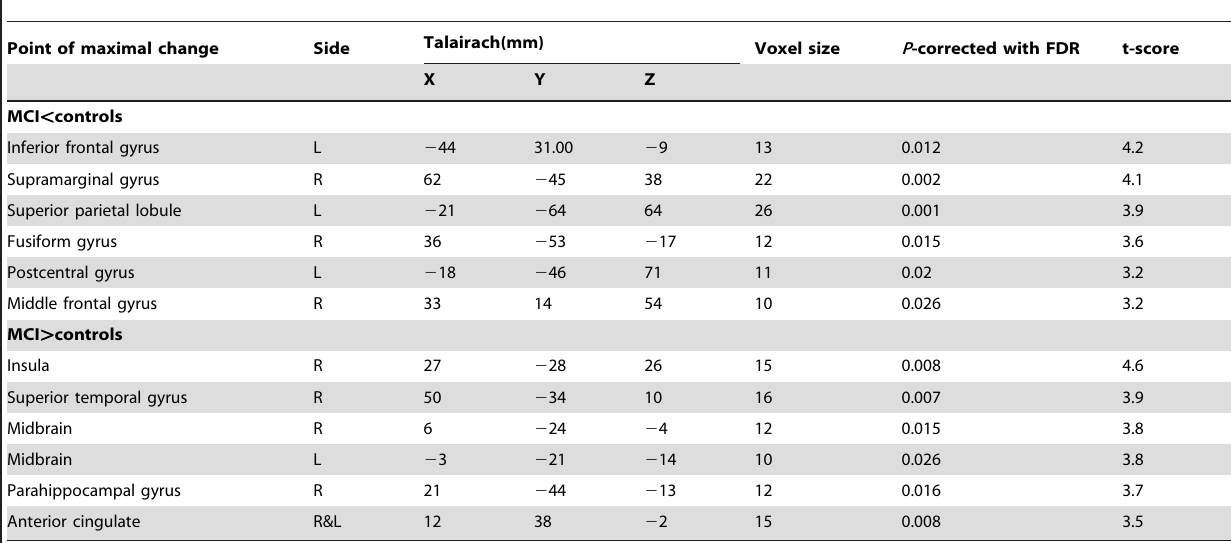
Table 2. ALFF analysis revealed both increased and decreased regional function in MCI group compared to